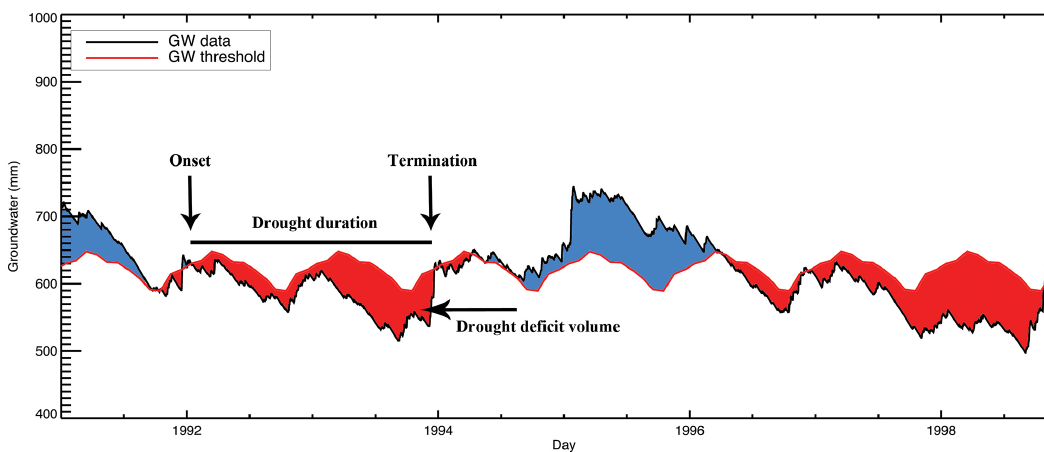
Figure 1. Groundwater storage modelled by LISFLOOD SFO in South-West Germany from 1990–1997.